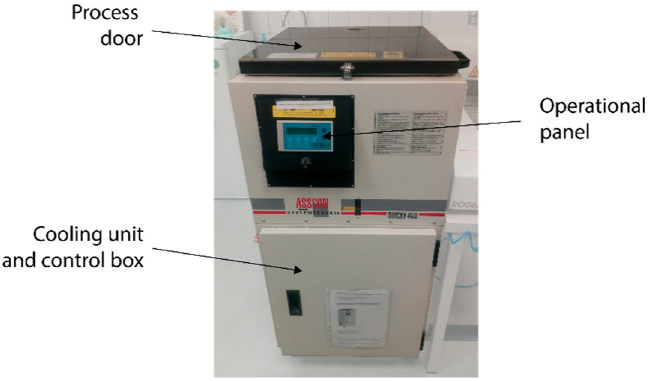
Figure 1. The applied VPS (Vapour Phase Soldering) oven. Figure 2.